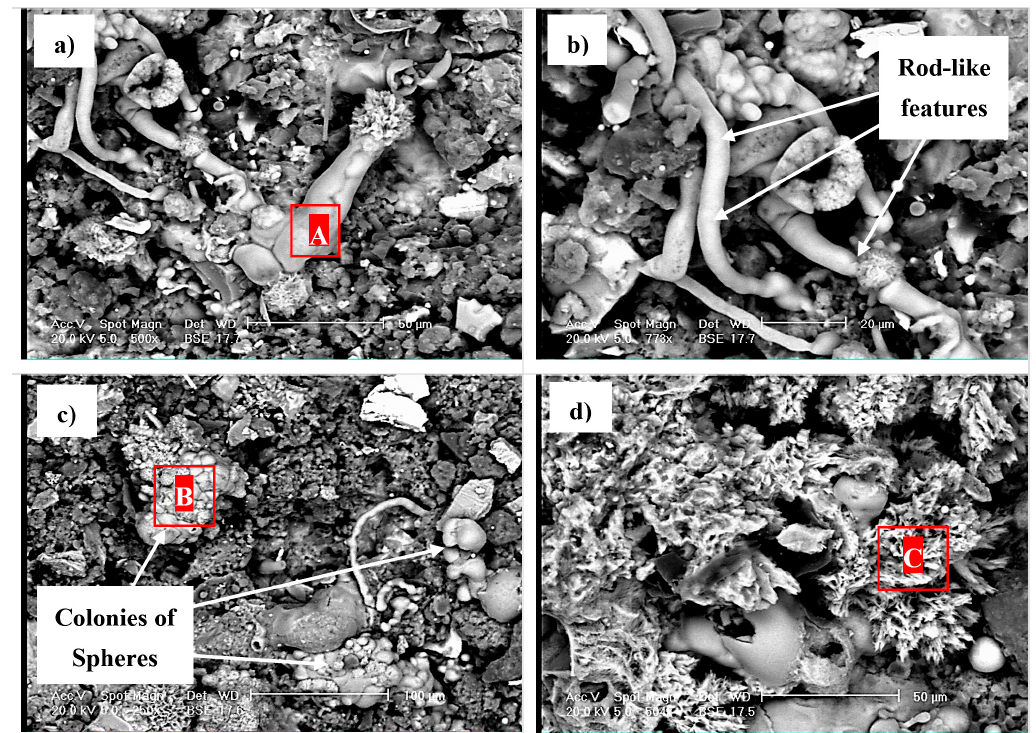
Figure 5. Scanning Electron Microscope (SEM) photomicrographs showing biofilms (or surface deposit) and features inside biofilms, i.e., ( a ) and ( b ) rod-like features, ( c ) colonies of spheres, and ( d ) flower-like features.